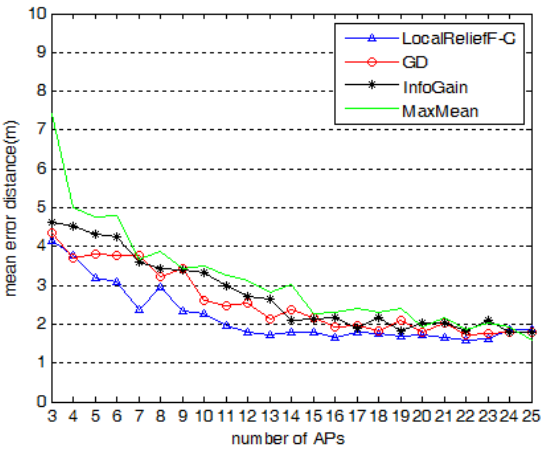
Figure 13. Mean error distances versus the number of APs.